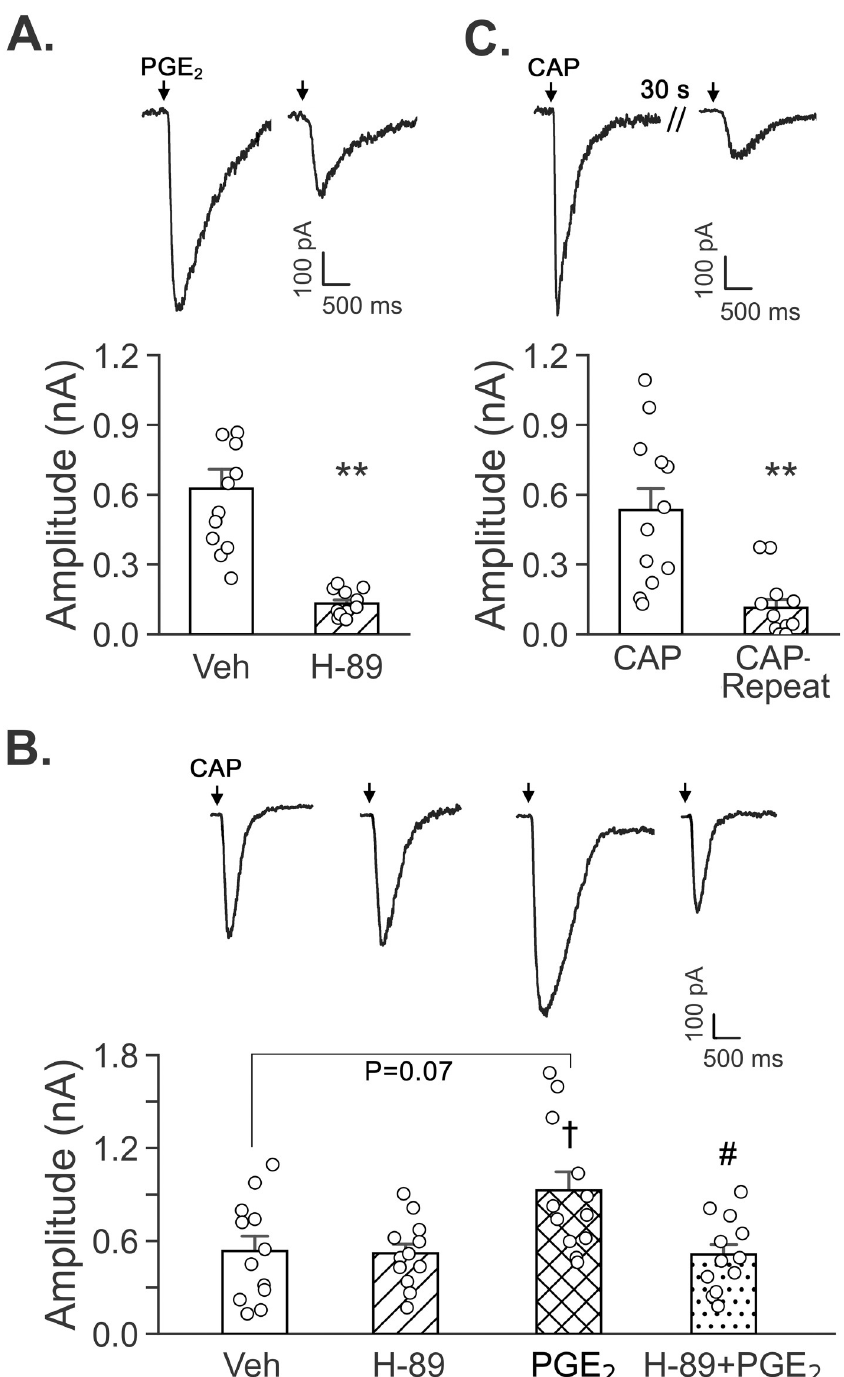
Fig 7. Effects of H-89 on PGE 2 -, CAP-, and PGE 2 +CAP-evoked currents and the desensitization of CAP-evoked currents by the first CAP in vagal pulmonary C-neurons. Typical recordings and the corresponding group data to show the impacts of H-89 (a PKA inhibitor) on the evoked currents in response to PGE 2 (A, n = 12), and CAP alone or CAP with PGE 2 pretreatment (B, n = 12). �� P < 0.01 as compared to the data without H-89, † and # P < 0.05, as compared to CAP alone (with Veh pretreatment) and PGE 2 respectively. C: Typical recordings to show the current responses to the first and second CAP in a vagal pulmonary C-neuron and the corresponding group data (n = 12). Compared to the first CAP ejection, the amplitudes of the currents evoked by the second ejecting CAP (CAP- Repeated) were markedly reduced. �� P < 0.001 as compared to the first CAP